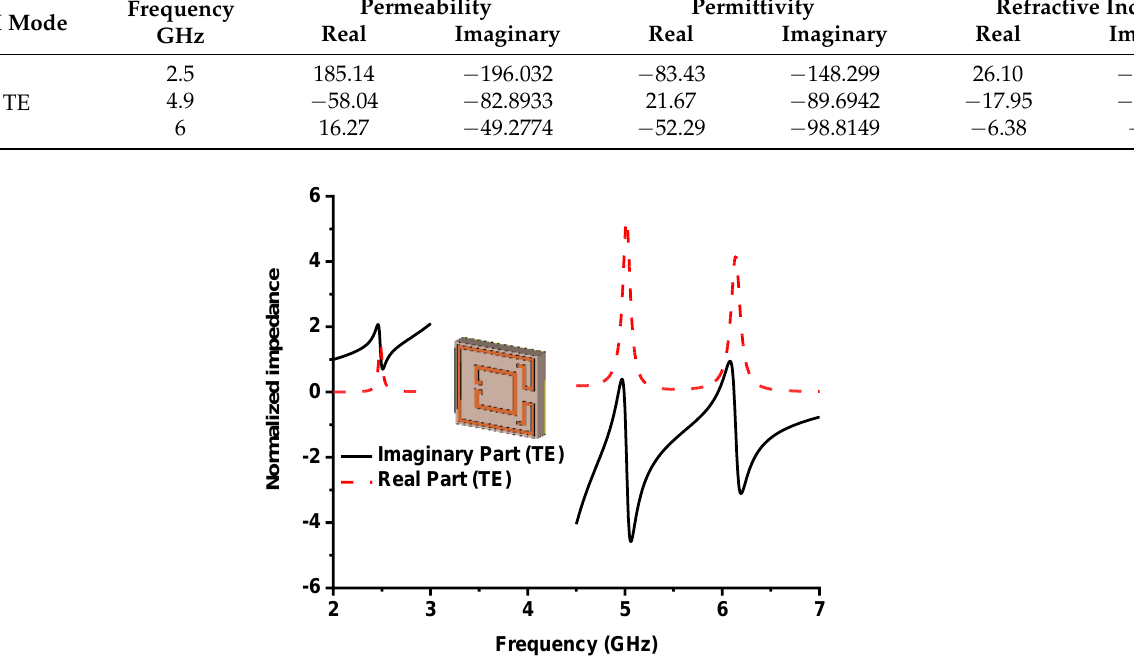
Figure 7. The normalized impedance of the proposed metamaterial absorber.